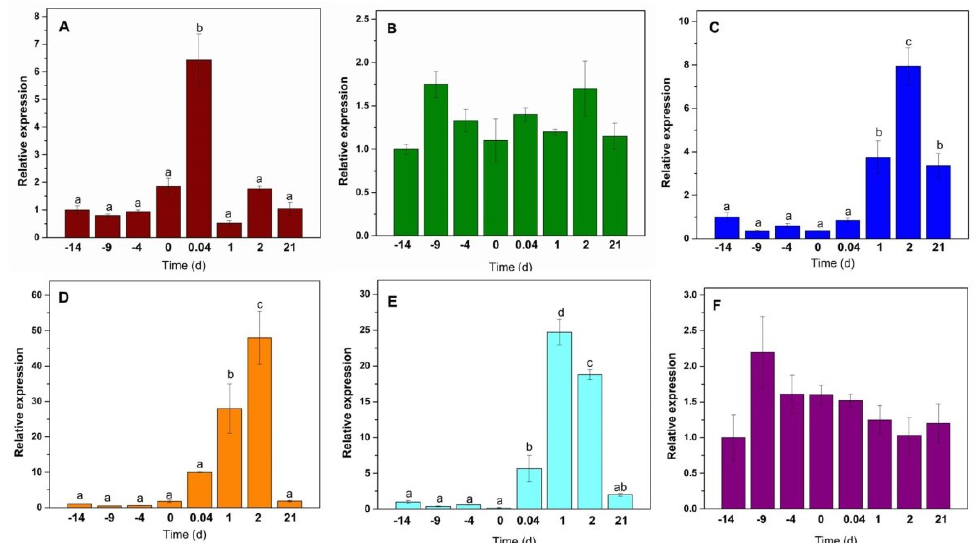
Figure 3. Expression profiles of selected CK biosynthesis and signal gene members in Coffea canephora . Y -axis values are relative expression (2 − ∆∆ CT method) averaged from 3 replicates. The X -axis represents sampling days in the SE process: ( A ) IPT1 ; ( B ) IPT5 ; ( C ) CKX3 ; ( D ) CKX9 ; ( E ) ARR2 ; ( F ) ARR9 . The relative transcript abundance was normalized using the C. canephora ubiquitin gene. Error bars represent standard error ( n = 3). Different letters represent the statistical significance of mean differences between each determination at a given time according to the Tukey test ( p < 0.05). For ( B , F ), there was no significant